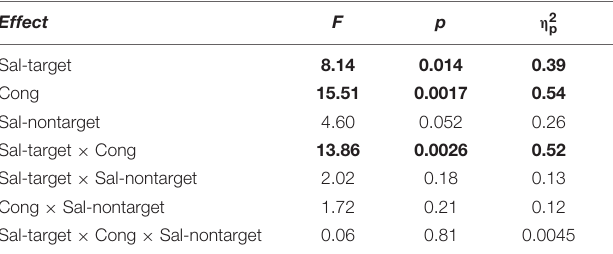
TABLE 2 | ANOVA results on error rates for visual